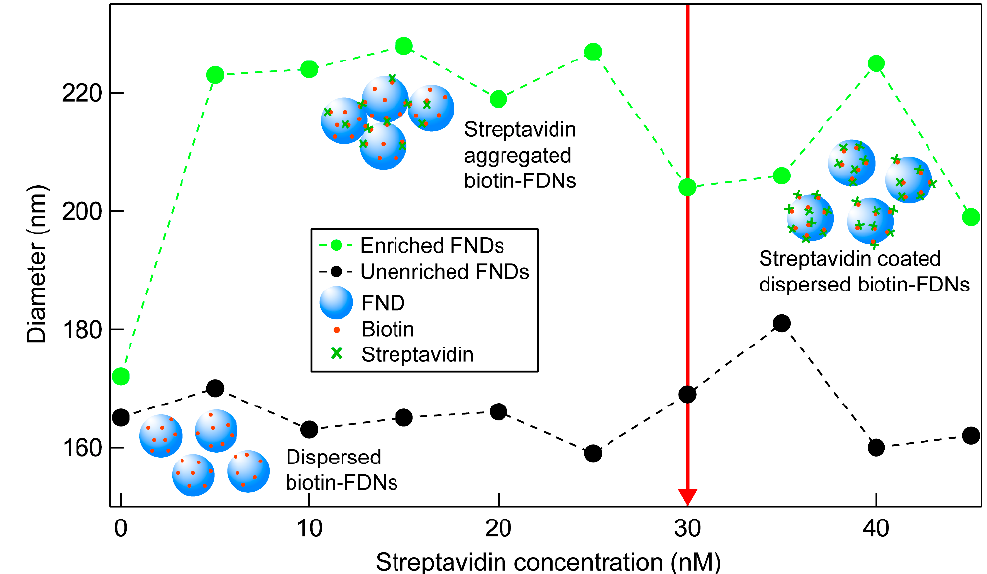
Figure 4. Quantification of biotin density on COOH-enriched and unenriched FNDs via dynamic light scattering measurement of streptavidin-induced aggregation. The hydrodynamic diameter of COOH enriched (green dots) and unenriched FNDs (black dots) after identical amine–PEG–biotin coupling reactions were measured as a function of streptavidin concentration. Streptavidin causes aggregation of biotinylated particles up to a critical concentration (~30 nM for COOH-enriched FNDs) at which all surface biotins on the particles are saturated and the diameter decreases to the size of the bare diamond with a layer of bound streptavidin (red arrow).